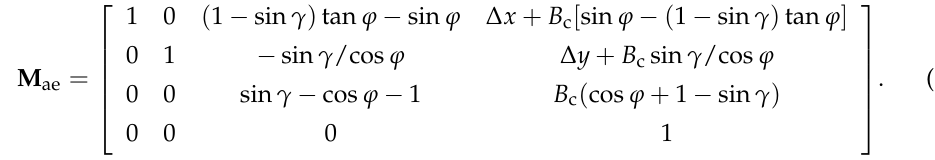
Figure 3. ( a ) Part of the tooth surface of cycloid gear considering PMs and MEs. ( b ) Definition of AEs. Figure 3b shows the definition of the AEs in this study. The AEs of cycloid gear and pin are equivalently transferred to the axis position of the cycloid gear to simplify the error tooth surface model. AB is the theoretical axis position of the cycloid gear without AEs, and A cae B cae is the new axis position of the cycloid gear when the AEs are considered. The AEs are indicated by four parameters, where ∆ x and ∆ y are called the center distance deviations, and ϕ and γ are the misalignment deviations on the XBZ -plane and the YBZ - plane, respectively. The different AEs can be obtained using different combinations of the above four parameters. The coordinates of the element control point i c × j c on the n th surface of the cycloid gear considering AEs are given as